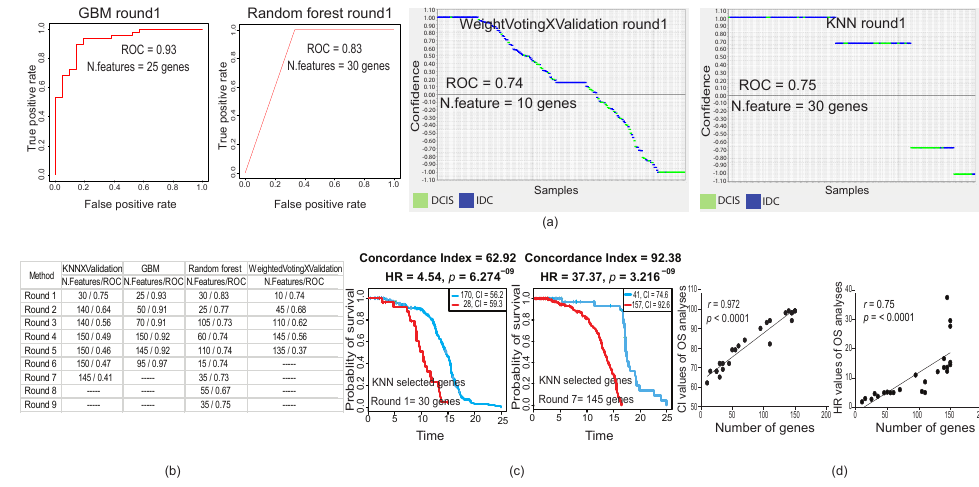
Figure 2. Machine-learning (ML) predictive models and survival analyses. ( a ) ROC plots and plots obtained by a prediction results viewer for the first round of feature selection by four di ff erent ML models. Separation of DCIS and IDC samples was achieved by both models. ( b ) ROC results of the first nine rounds of feature selection. After each round of feature selection, we excluded this gene list feature from the DEG source and repeated it for a new feature selection. Note that we did not continue feature generation if ROC / AUC was constant or dropped below 0.5. ( c ) Kaplan-Meier survival analyses of the first and the last rounds of gene feature selection optimized using the KNN model. Note that the last feature with ROC below 0.5 (panel b) also strongly correlated with survival. All log rank tests were significant ( p < 0.05; p -value generated by SurvExpress online server). ( d ) Correlation of concordance index (CI; left) and hazard ratio (HR; right) obtained from overall survival (OS) analyses with the number of genes in each gene feature (see Figure S2b; Pearson correlation